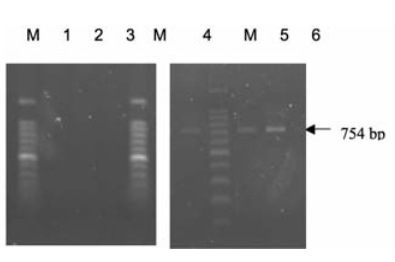
and they were denatured to smaller sub- units.